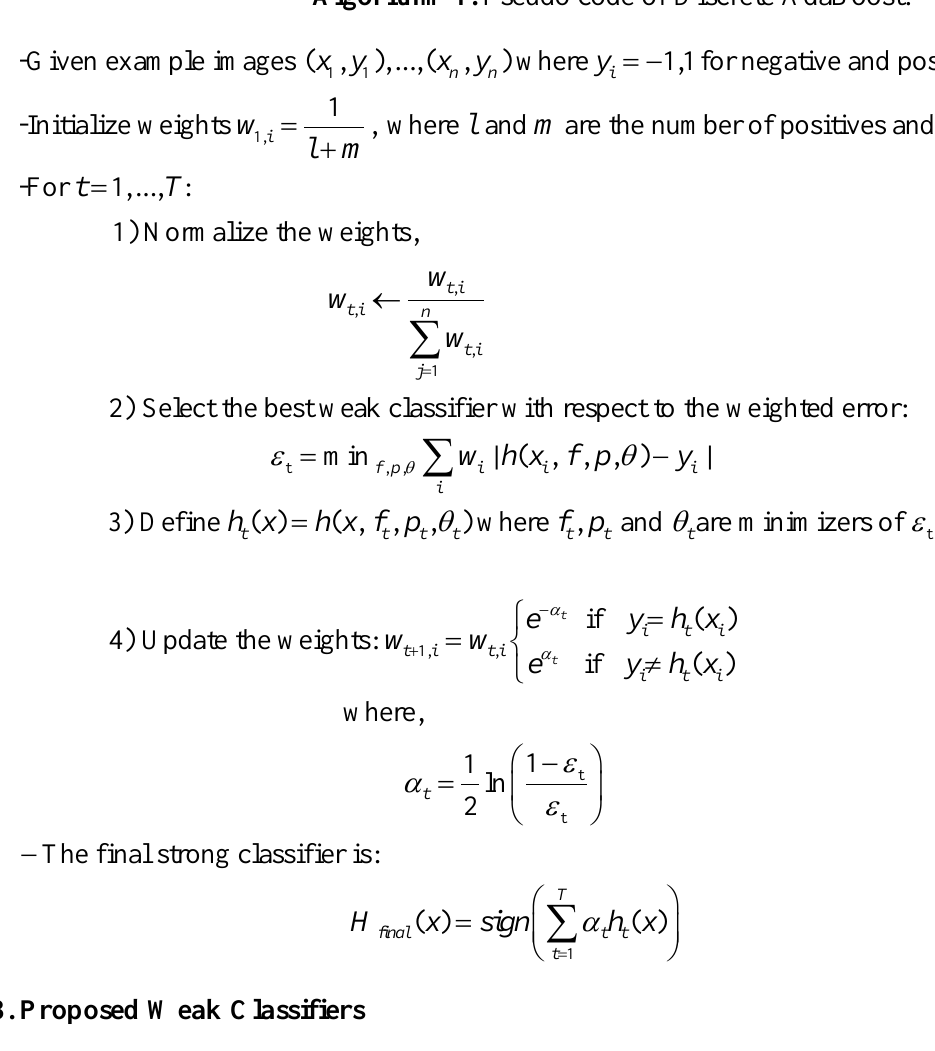
Algorithm 1. Pseudo code of Discrete